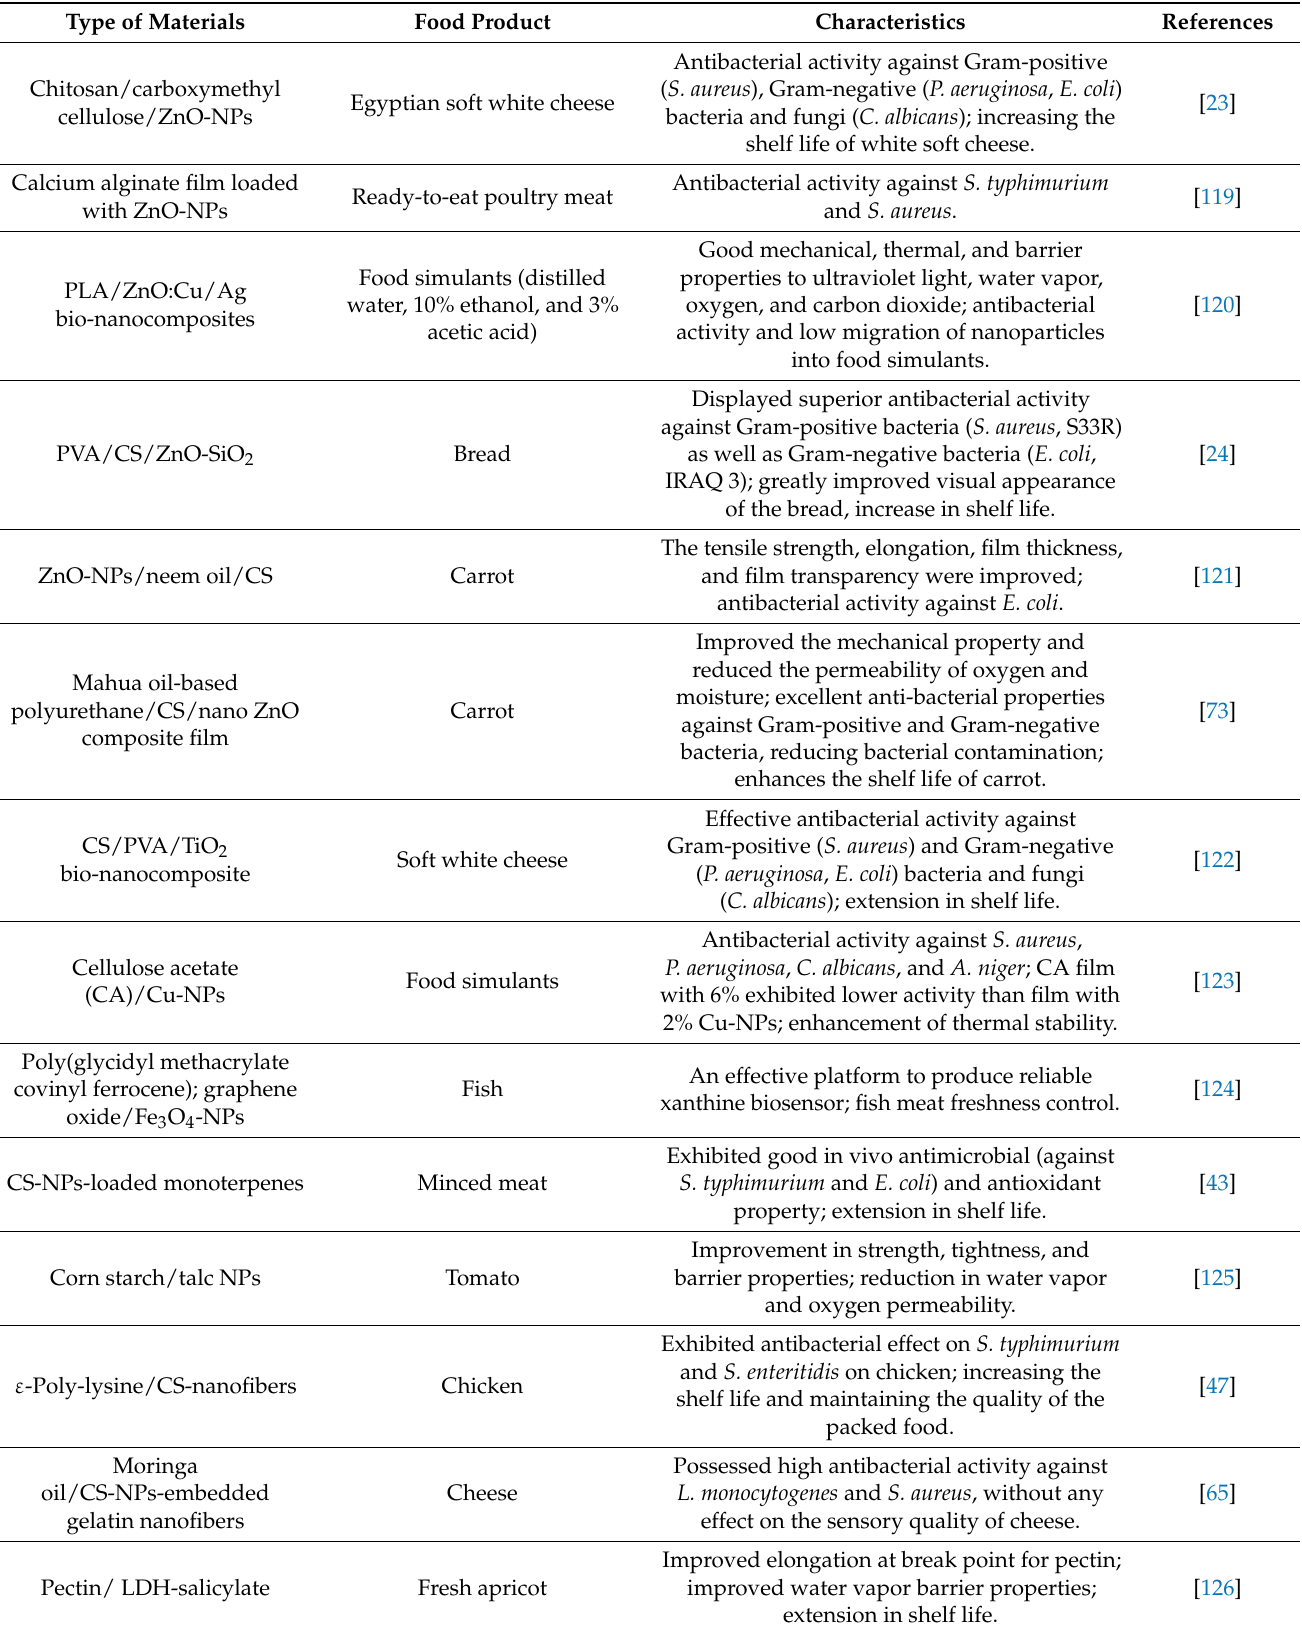
Table 1. Different types of novel bio-based antimicrobial materials in food